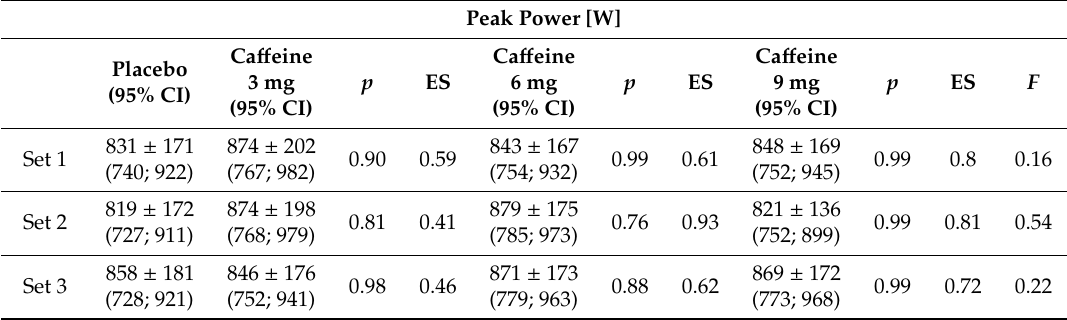
Table 2. Results of peak power output in three successive sets of the bench press exercise in the group that ingested di ff erent doses of ca ff eine, and the placebo